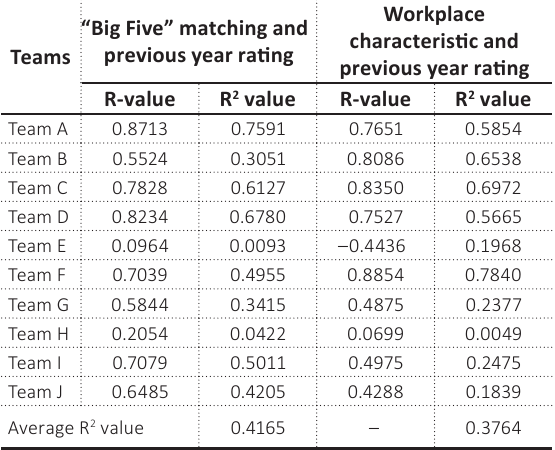
Table 3. Regression analysis of idiosyncratic rater effect